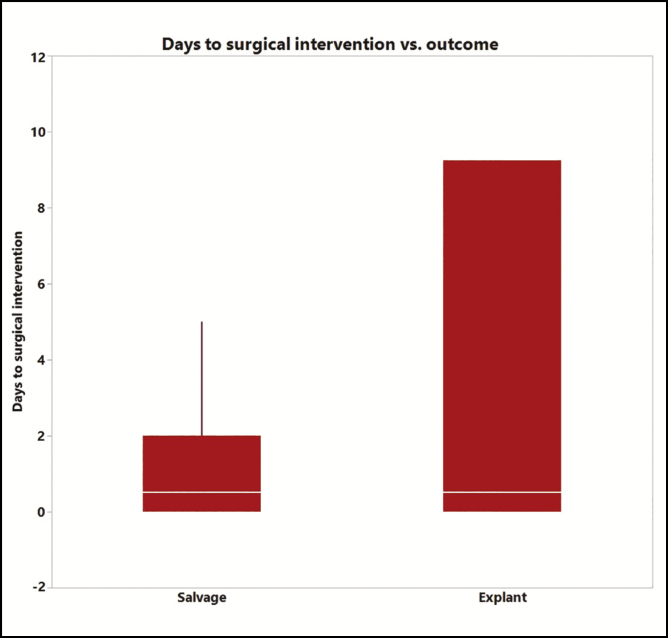
Time (in days) between fluid sampling and outcome (salvage vs explant).